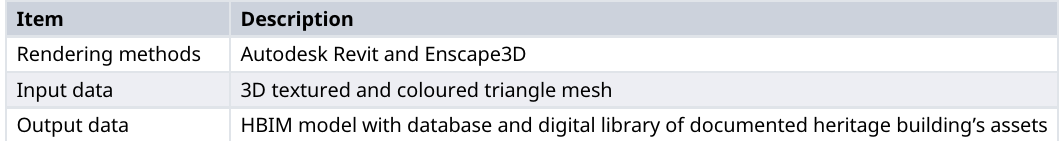
Table 4. Rendering phase for the Société Immobilière building.